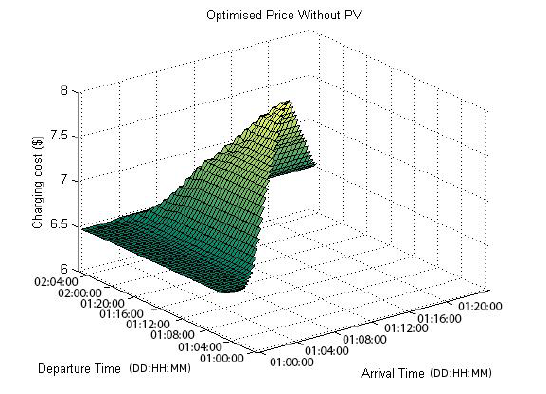
Figure 12: Optimised Charging cost without PV.